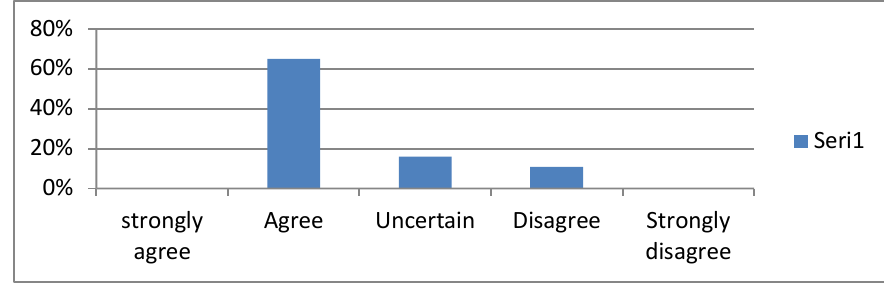
Figure 13 : recommend the service